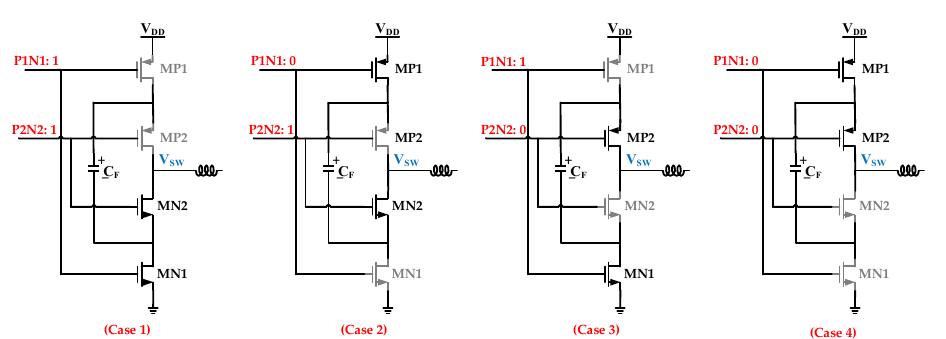
Figure 8. Block diagram of 3L- SWR.